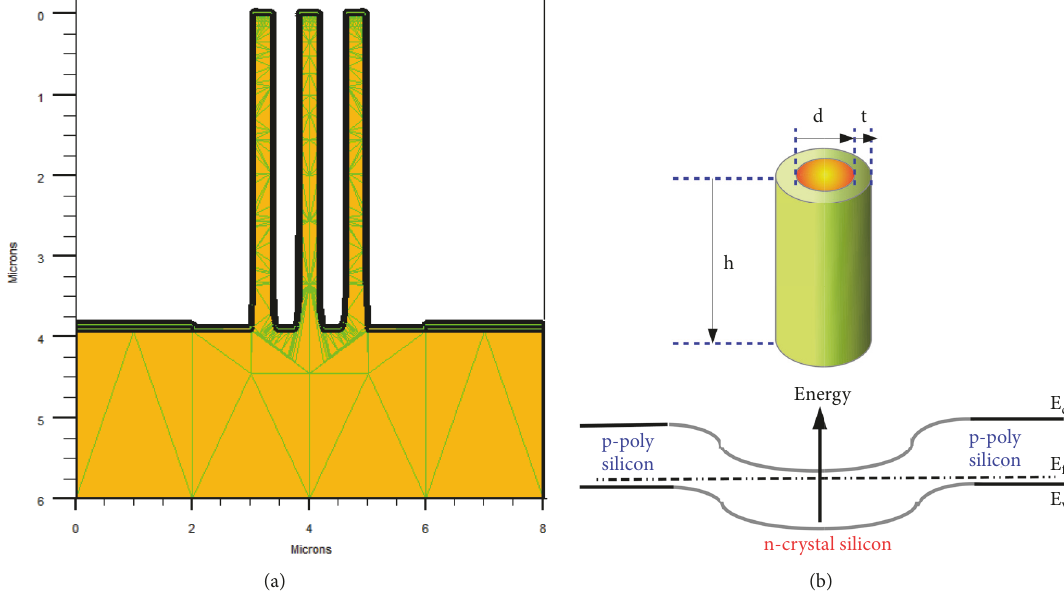
Figure 2: ( a ) Cross section of the radial junction nanowire cell; ( b ) energy band diagram of a single nanowire core-shell junction solar cell.